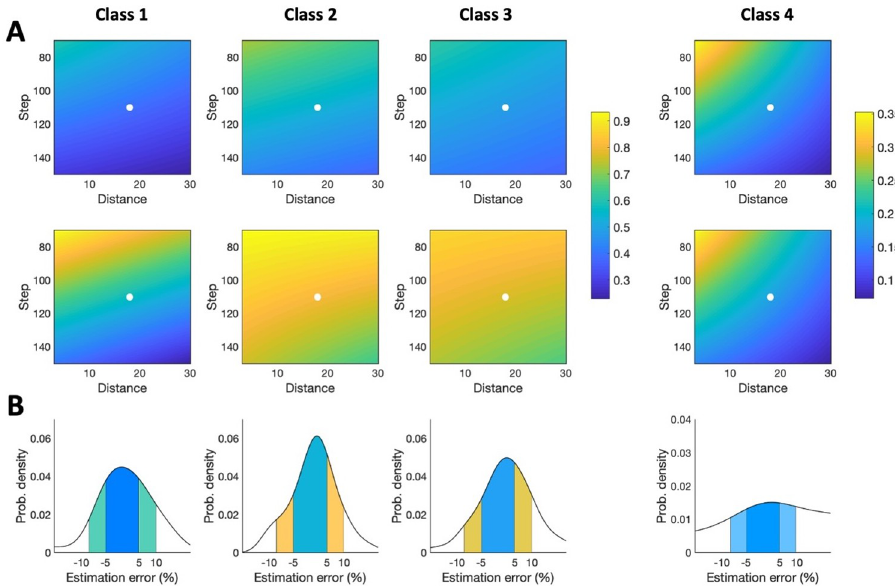
Fig 8. Error probability distribution for axon length estimation by planes-based stereology. A . Probability of ± 5% (first row) and ± 10% (second row) axon length estimation error for different combinations of distance and step, and for axon classes 1 to 4 (columns); probability is marked by color gradient, from 0.25 to 0.92 (see color bar). Probabilities for classes 1, 2, and 3 are plotted with the same colored-scale. White dots point to the cases for distance = 18 μ and step = 110 μ . Values were obtained through linear interpolation (Adjusted R-squared for 5% error: class 1 = 0.80, class 2 = 0.86, class 3 = 0.81, class 4 = 0.91; Adjusted R-squared for 10% error: class 1 = 0.83, class 2 = 0.83, class 3 = 0.85, class 4 = 0.93). B . Error probability distribution for the particular cases detailed in A. The areas below the curves are the probabilities shown in A and pointed with the white dots.